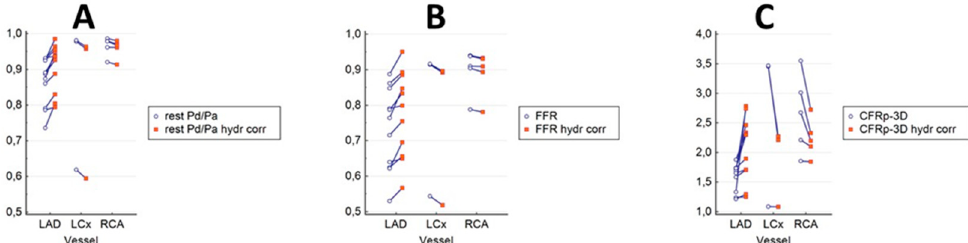
Figure 6. Clustered multiple variable graphs of resting Pd/Pa, FFR, and CFRp-3D without and with hydrostatic pressure correction. In both the resting and the hyperemic (FFR) state ( A , B ), the correction of the hydrostatic offset resulted in differences in consequent directions between the uncorrected and corrected values in the main coronary branches. The correction significantly increased the values in the LAD, while in the LC and the RCA the values decreased. Much greater differences in the same direction can be observed for the CFRs, especially in the range of the higher values ( C ).